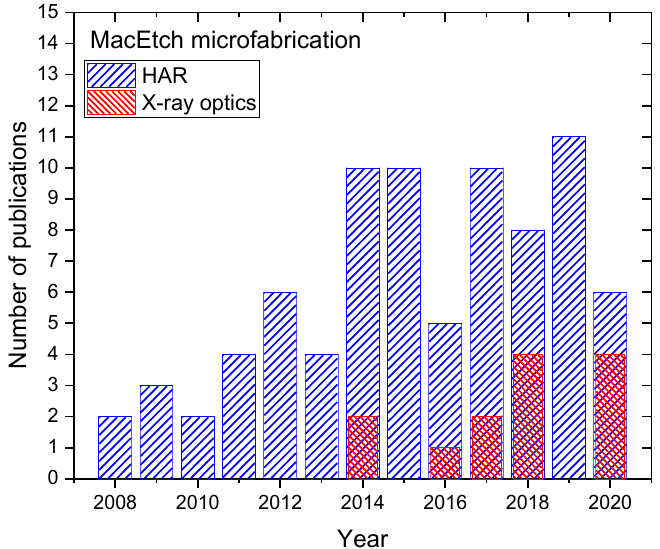
Figure 14. Number of publications as a function of year regarding MacEtch for producing high aspect ratio (HAR) patterned structures [2,8,15,17,18,21,24–26,31,32,35–41,43,47,50,51,54,56–58,62,63,71,73,77,78,93,105–153] and specific for X-ray optics fabrication [17,18,21,35– 41,93,119,126,153].